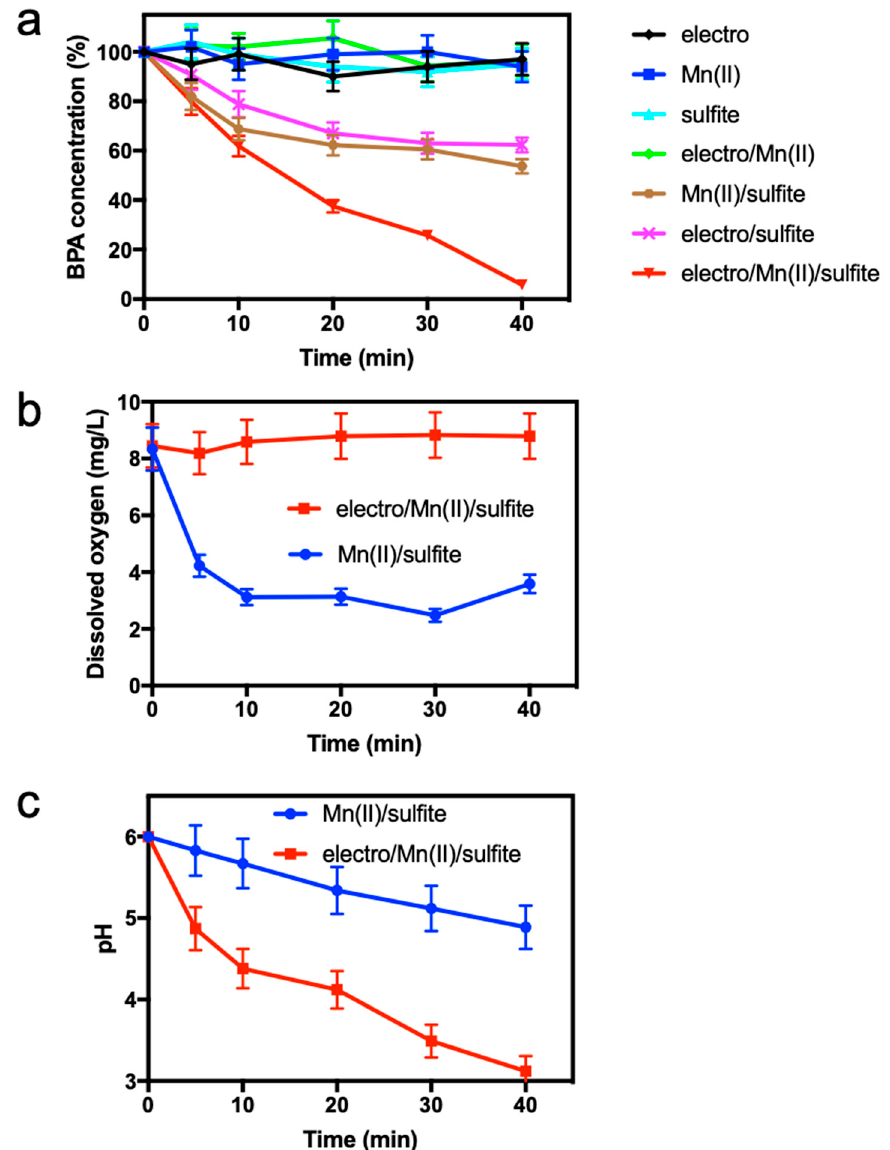
Figure 2. Removal of bisphenol A (BPA) by the electro / Mn(II) / sulfite process. ( a ) BPA removal by several controls; ( b ) dissolved oxygen in the solution changes in Mn(II) / sulfite and electro / Mn(II) / sulfite processes; and ( c ) solution pH changes in Mn(II) / sulfite and electro / Mn(II) / sulfite processes. Reaction conditions: 0.2 mM Mn(II), 2 mM sulfite, 5 mM sulfate as supporting electrolyte, 10 µ M BPA, 100 mA electric current, and pH 6.